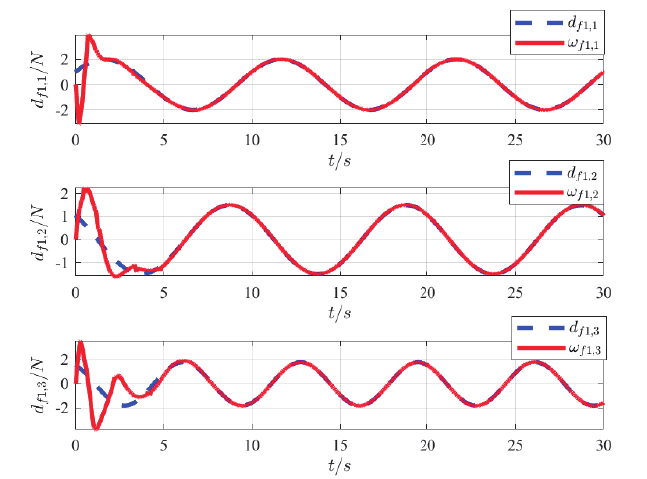
Figure 11. Observation results of